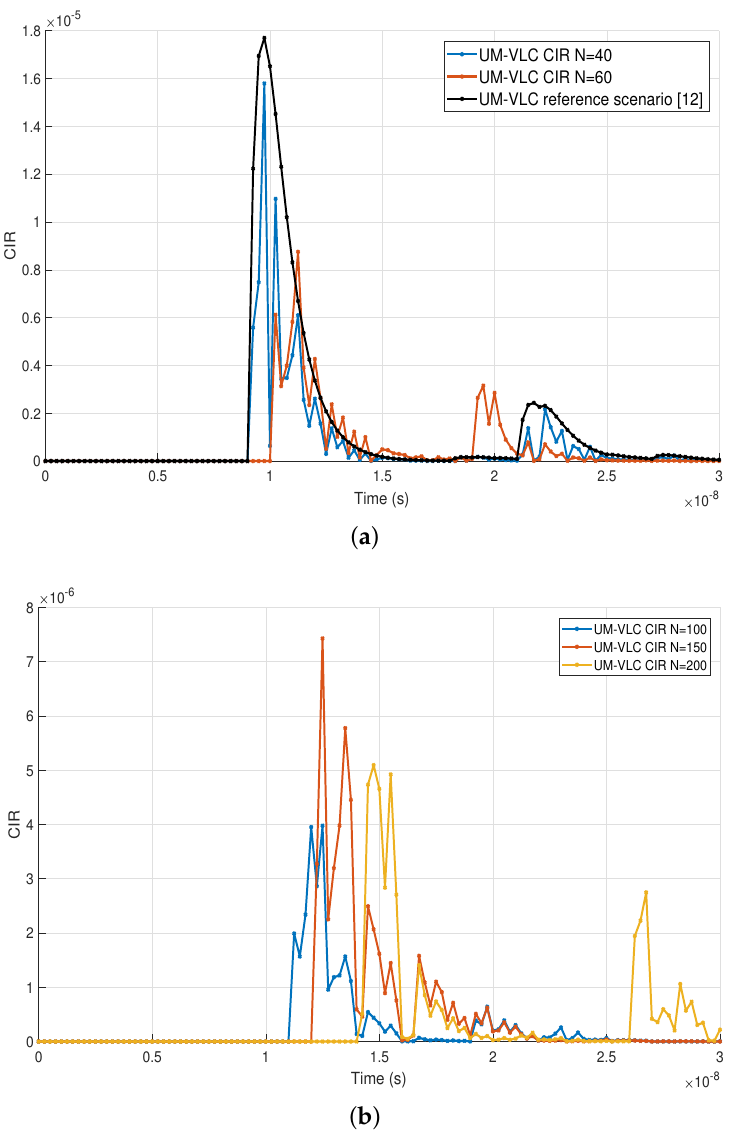
Figure 3. UM-VLC CIR curves for ( a ) 40 and 60 dust particles in the hemispheric area, and UM- VLC reference scenario, Reprinted from ref. [12], and ( b ) 100, 150, and 200 dust particles in the hemispheric